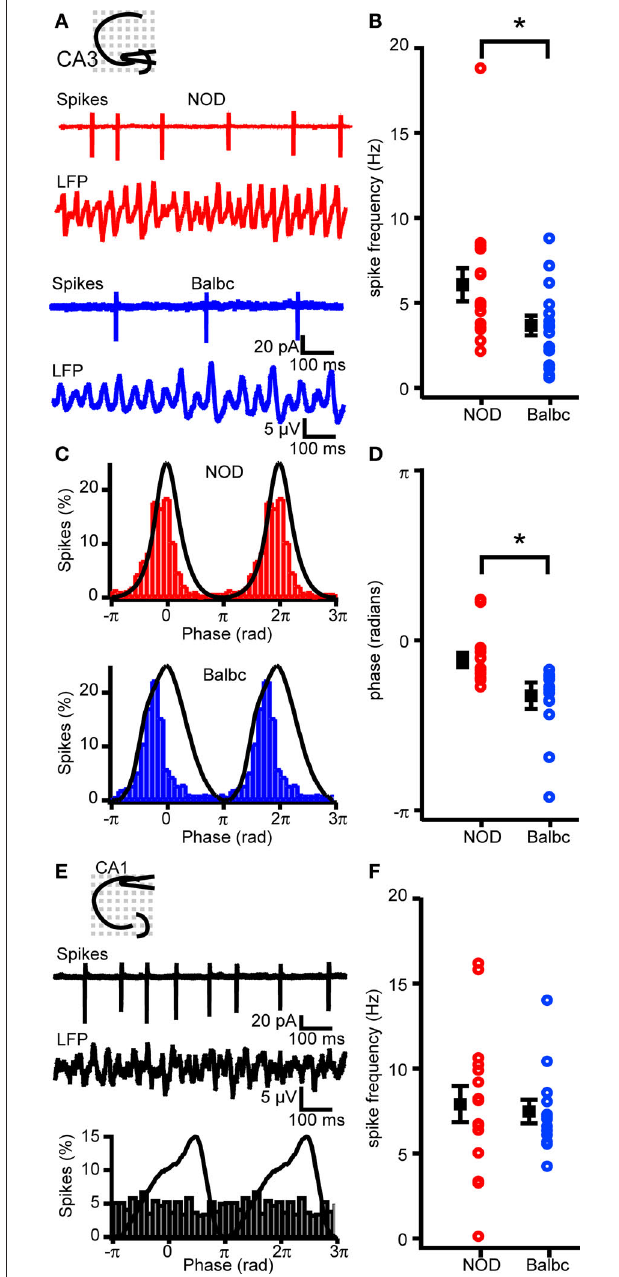
FiGuRe 7 | Spike timing and frequency differs between NOD and Balbc mice. (A) Example traces of spikes recorded from CA3 pyramidal cells in cell-attached mode and field potential in NOD and Balbc mice. (B) Average firing frequency of CA3 pyramidal cells in NOD ( n = 16) is higher than in Balbc ( n = 16, p < 0.05) mice. (C) Average waveform of the field oscillation spike probability histogram at different phases of the oscilation from a cell from a NOD (top) and a Balbc (bottom) mouse. (D) I. Average phase of spikes. Spikes in CA3 pyramidal cells from Balbc mice occur at a earlier phase than in NOD mice ( p < 0.05). (e) Example traces of spikes recorded from CA1 pyramidal cells from a Balbc mouse in cell-attached mode and field potential (top) and average spike probability histogram at different phases of the oscillation (bottom). (F) Average firing frequency of CA1 pyramidal cells in NOD and Balbc mice. Average values + SEM are shown in